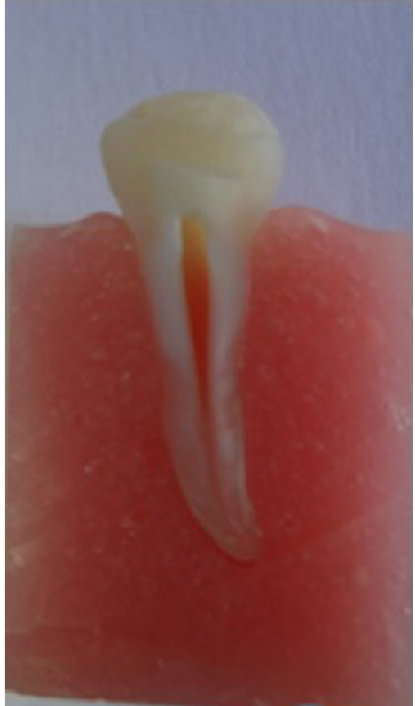
Figure 2. Sample was sliced into two halves through the middle.